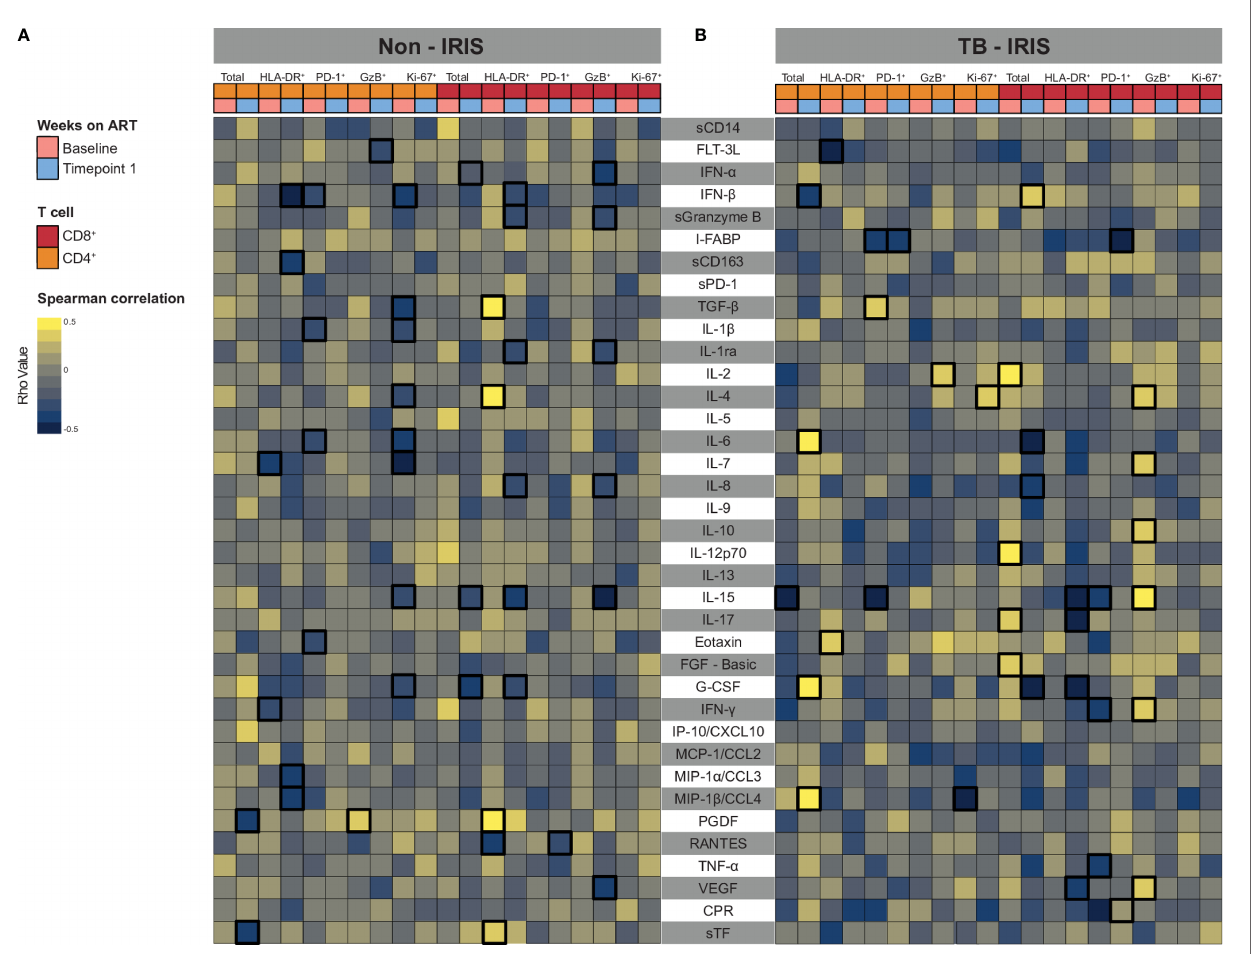
FIGURE 4 | Associations between both CD4+ and CD8+ T lymphocytes expressing activation-related biomarkers and plasma levels of several in fl ammatory biomarkers. A heatmap was employed to depict the strength of association between CD4+ and CD8+ T cells expressing activation-related biomarkers and the level of circulating cytokines and chemokines at Baseline (prior to ART) and after approximately 2 to 6 weeks following ART initiation (Timepoint 1) for Non-IRIS patients (A) and individuals who experienced TB-IRIS manifestations (B) . Statistically signi fi cant correlations (P<0.05) after adjustment for multiple measurements are highlighted with bold